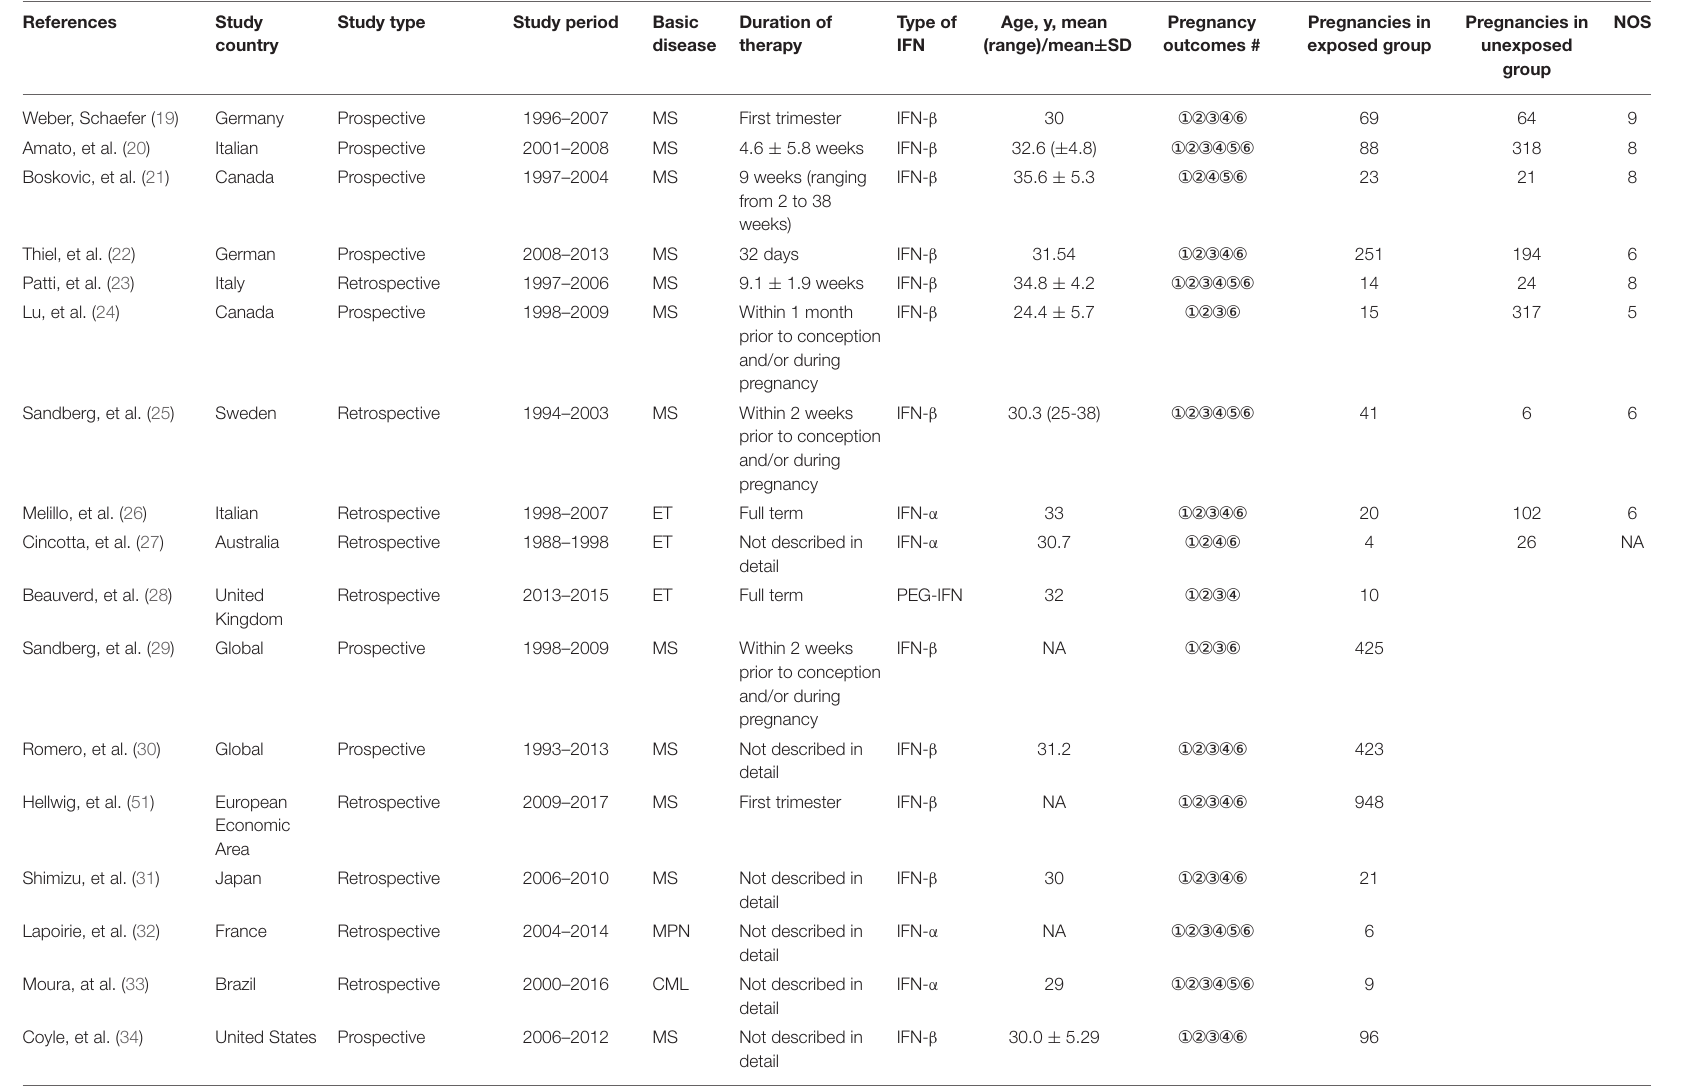
TABLE 1 | Characteristics of the 17 included studies for